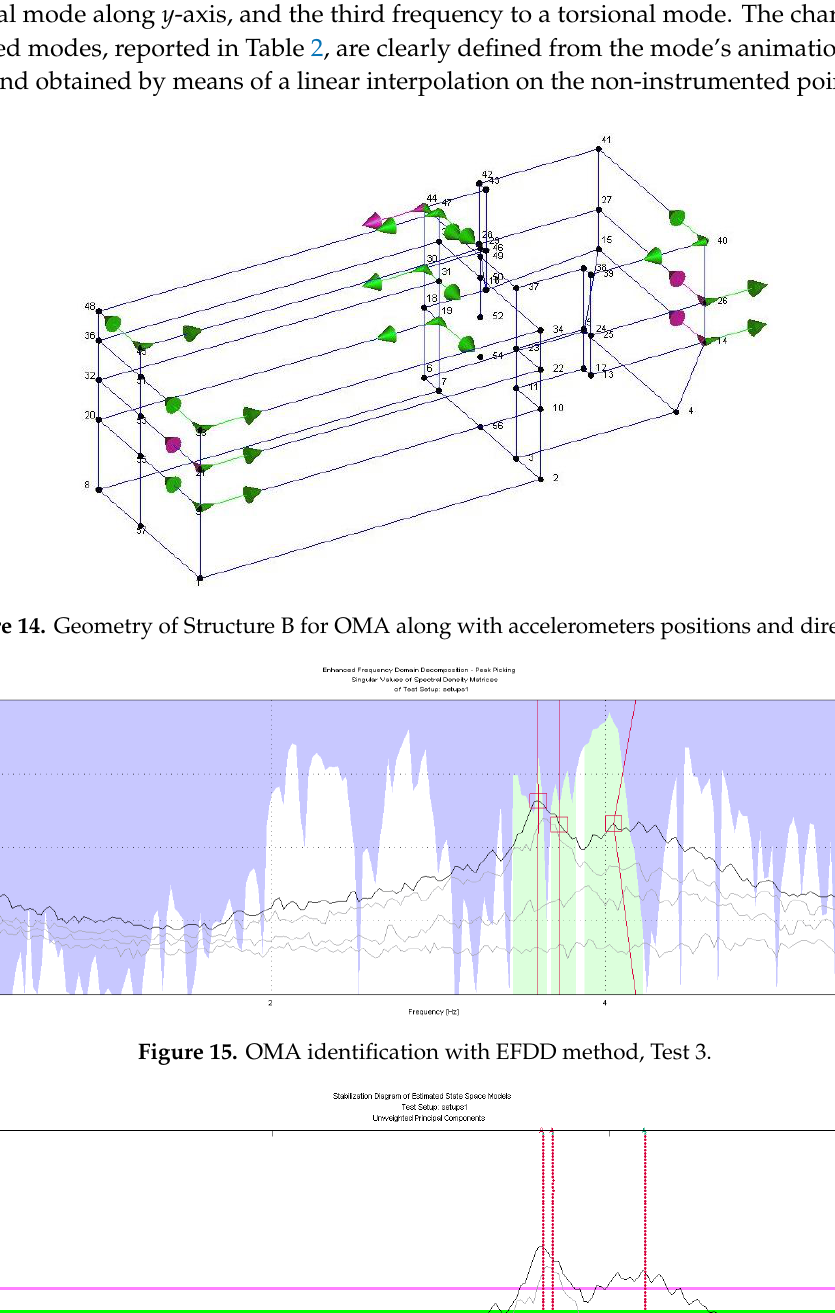
( b ) Figure 13. ( a ) Accelerometer time-history in point I, x direction; ( b ) accelerometer time-history in point F, y direction. OMA for Structure B The geometric model considered, shown in Figure 14, reports the points, the reference system xyz and the accelerometers location and direction (represented as arrows); in correspondence to point F, that is point 23 in the model in Figure 14, no accelerometer has been considered. The diagrams of EFDD analysis and CC–SSI analysis for Test 1 are shown in Figures 15 and 16. The first three identified frequencies in the range [0–6 Hz] and the description of the corresponding modes for all the analyzed test (Test 1, Test 2, and Test 3) and for both techniques (SSI in the time domain and EFDD in the frequency domain) are summarized in Table 2. Moreover, for Structure B, the repeatability of the three identified frequencies on different tests and with different techniques is